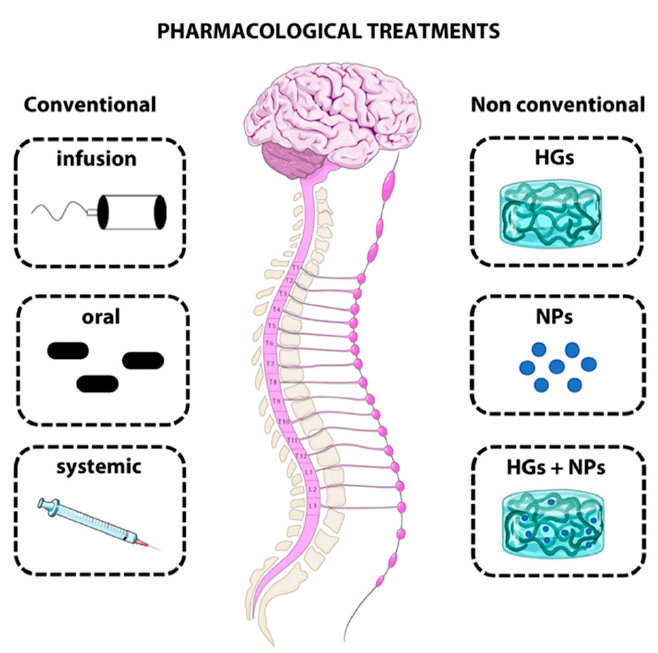
Figure 1. Schematic overview of conventional and non-conventional delivery strategies for SCI treatment.